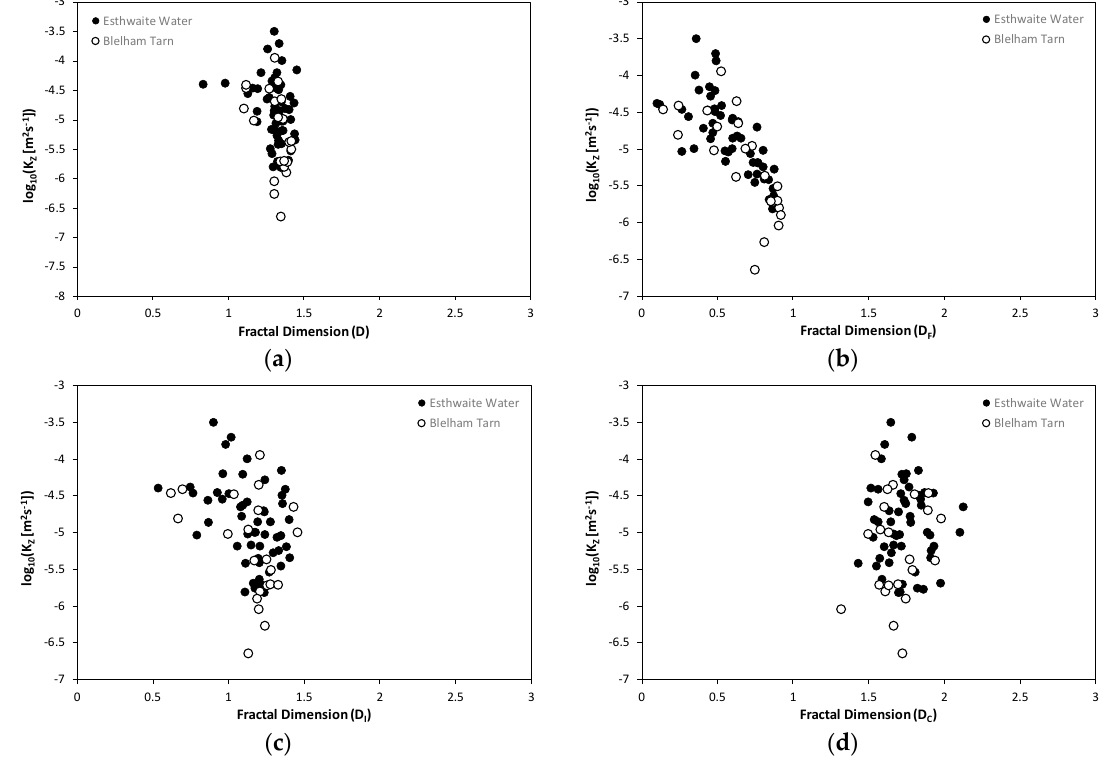
Figure 12. Plots of log 10 ( K Z ), calculated using the Batchelor method, against ( a ) D ; ( b ) D F ; ( c ) D I ; and ( d ) D C . Data from all depths bins, all profiles and all dates